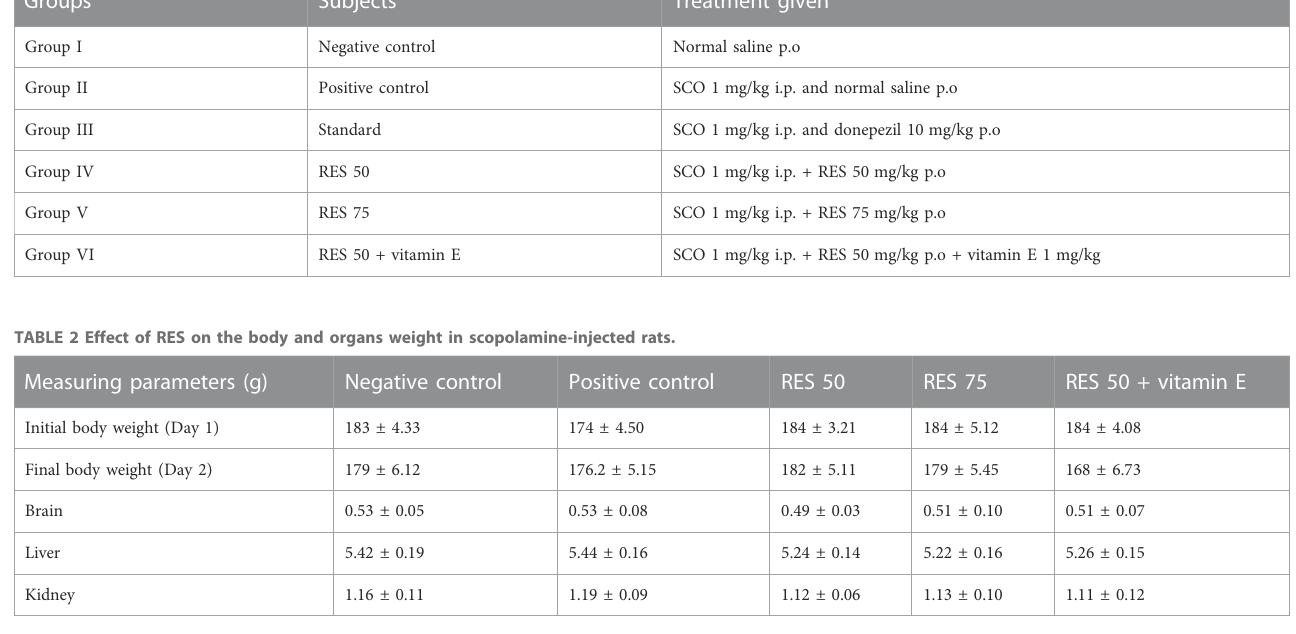
TABLE 1 Grouping of animals. Groups